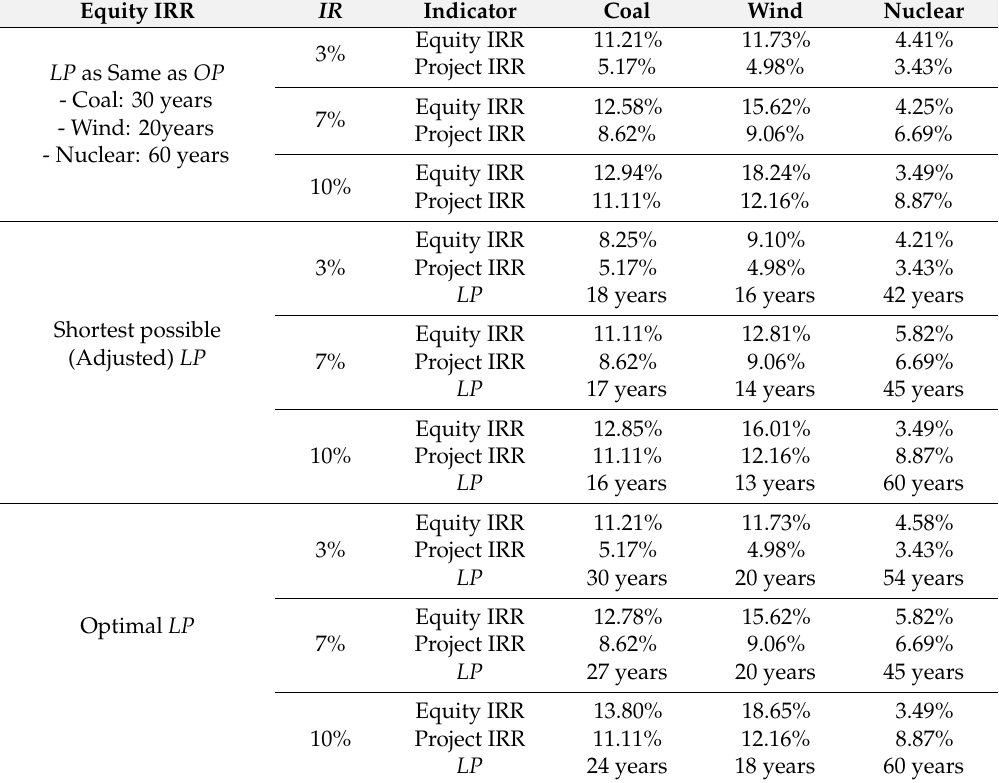
Table 7. IRR values of Coal, Wind, and Nuclear for original, adjusted, and optimal